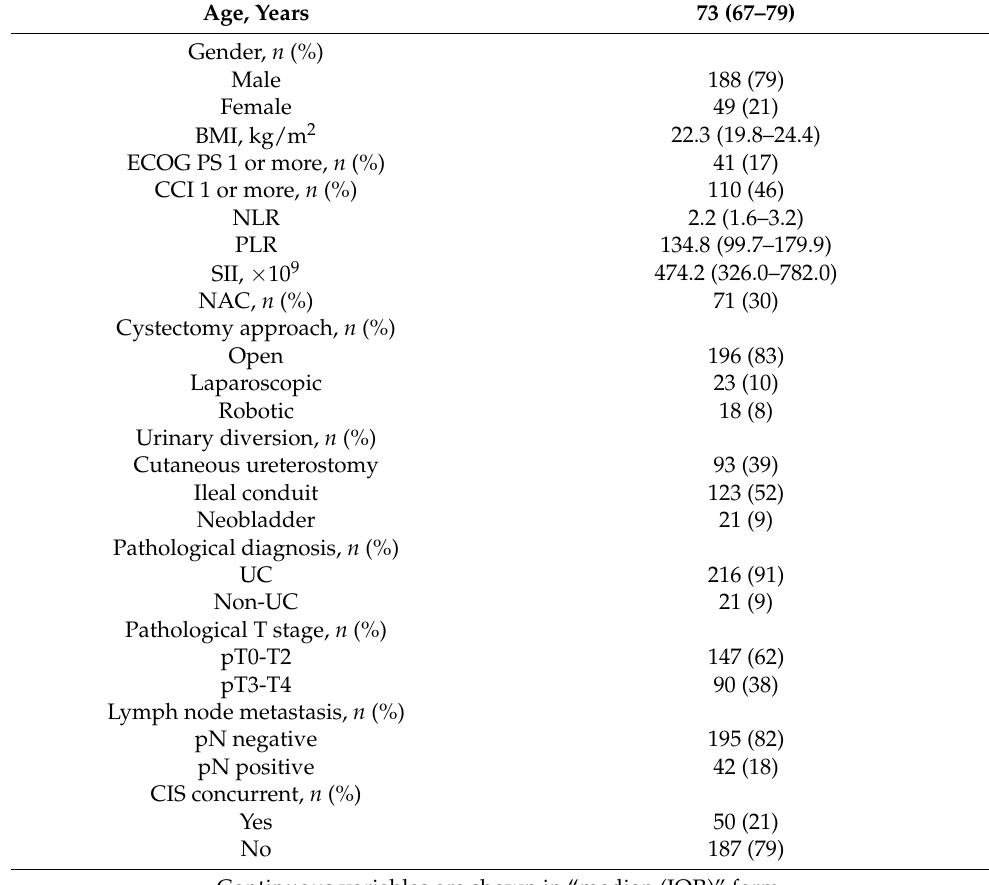
Table 1. Patient characteristics ( n =